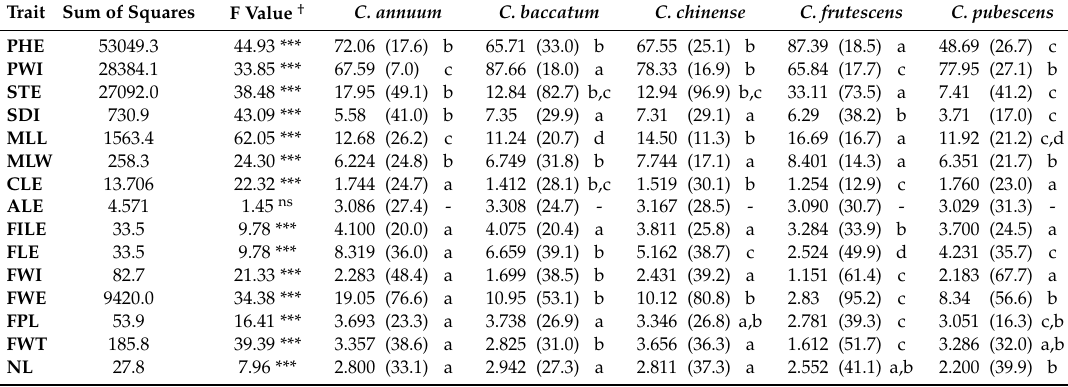
Table 2. Analysis of variance for quantitative conventional descriptors among the five Capsicum species (left). Mean (Coe ffi cient Variation %) for each group (right). Di ff erent letters within the same row indicate significant di ff erences at p < 0.05. PHE = Plant height, PWI = Plant width, SLE = Stem length, SDI = Stem width, MLL = Mature leaf length, MLW = Mature leaf width, CLE = Corolla length, ALE = Anther length, FILE = Filament length, FLE = Fruit length, FWI = Fruit width, FWE = Fruit weight, FPL = Fruit pedicel length, FWT = Fruit wall thickness, NL = Number of